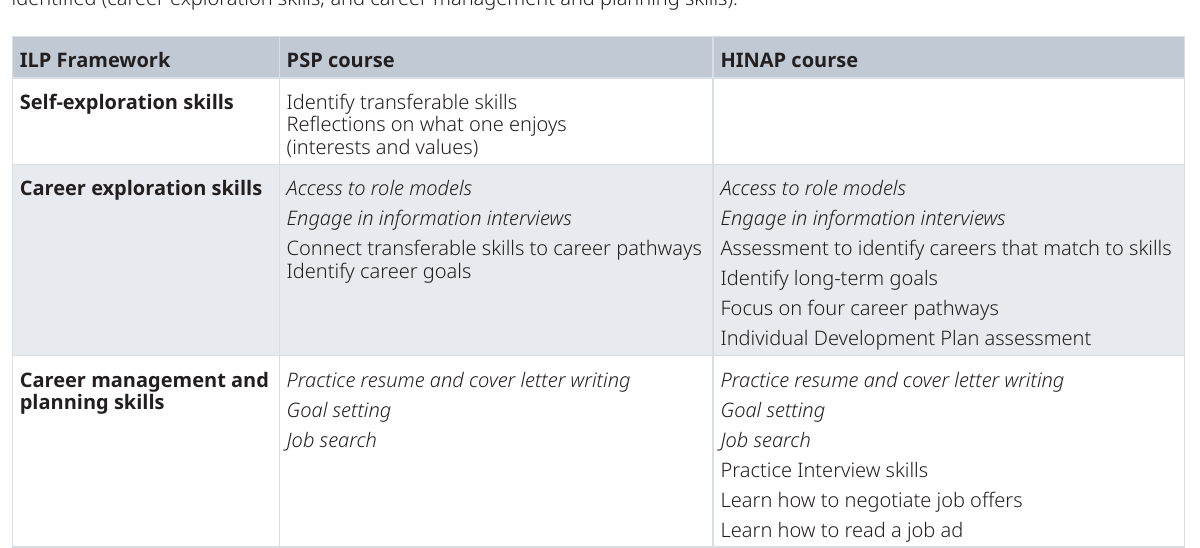
Table 1. Thematic analysis of biomedical course syllabi using the ILP Career Development Framework. Comparison of PSP Course and the HINAP Course using an ILP Framework identifies two common areas of career development themes identified (career exploration skills; and career management and planning